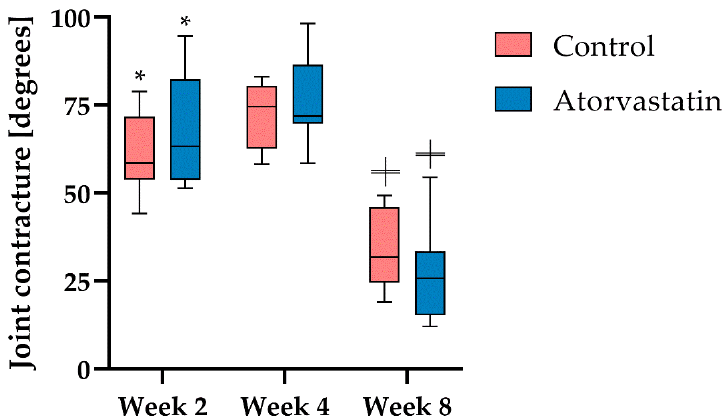
Figure 3. Overall joint contracture after immobilization at week 2 (n = 8 per group) and week 4 (n = 8 per group) and after remobilization at week 8 (n = 8 (atorvastatin); n = 7 (control)). Data are presented as boxplots with median, minimum and maximum. Significant differences to the respective baseline value are marked with * ( p < 0.05), and significant differences to the contracture at week 4 are indicated with ╪ ( p < 0.01).